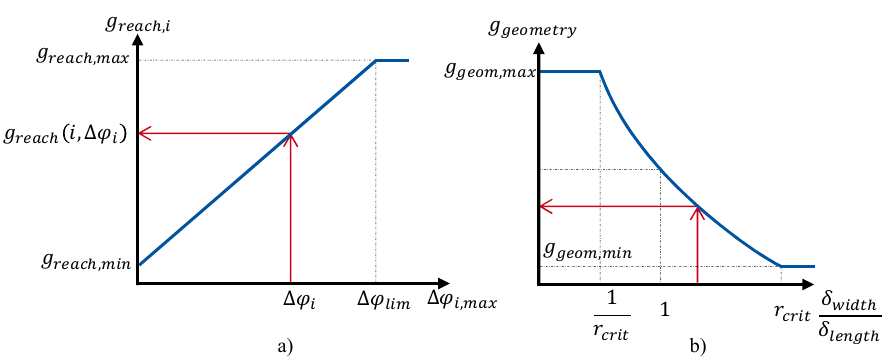
Figure 16. Weights calculation of: ( a ) g reachability ; and ( b ) g geometry